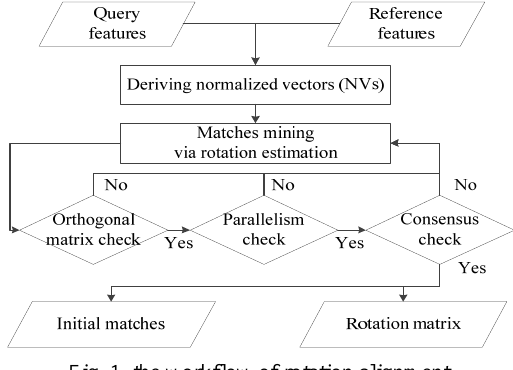
Fig. 1. the workflow of rotation